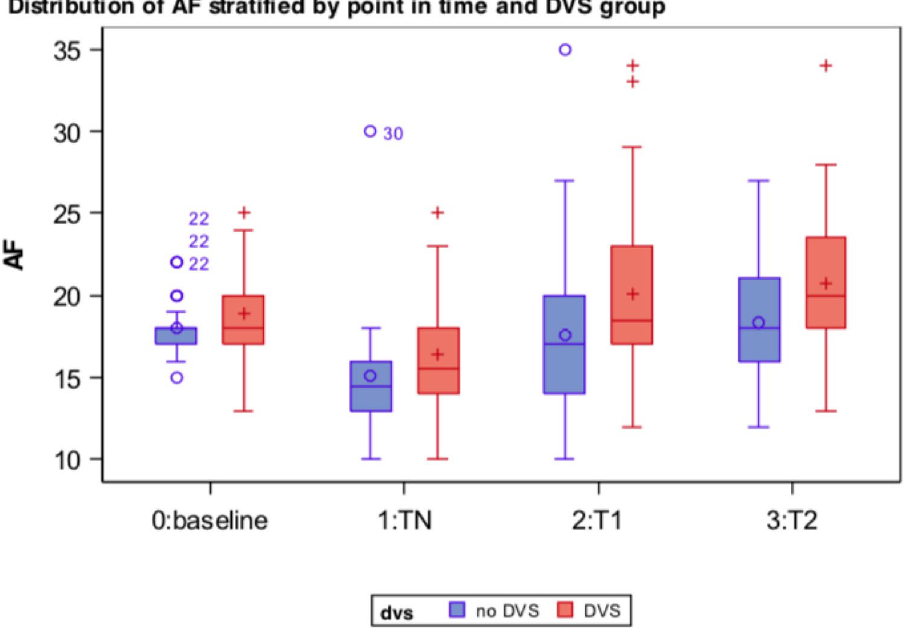
Figure 2. Respiratory rate in subgroups DVS/nDVS stratified by